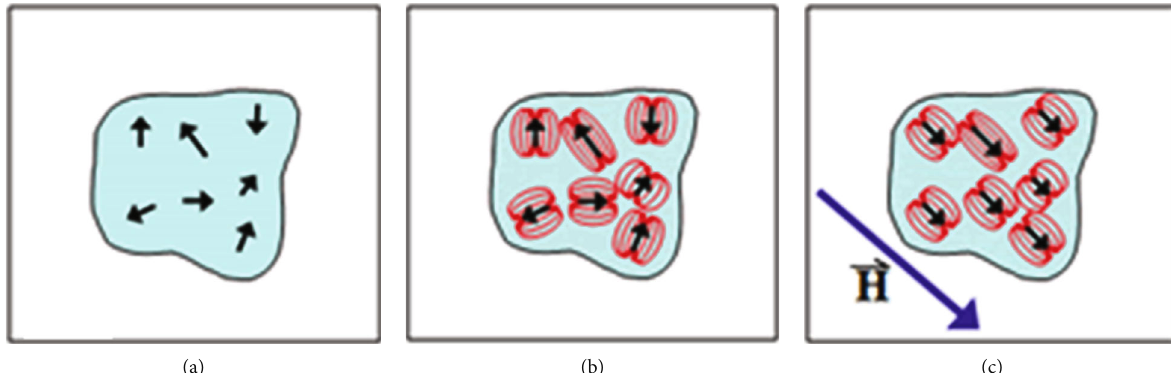
Figure 5: (a) No external fi eld, and the rock sample has zero net fi eld. (b) Magnetic domains are oriented randomly. (c) If an external fi eld H exists, magnetic domains will align to it [20].